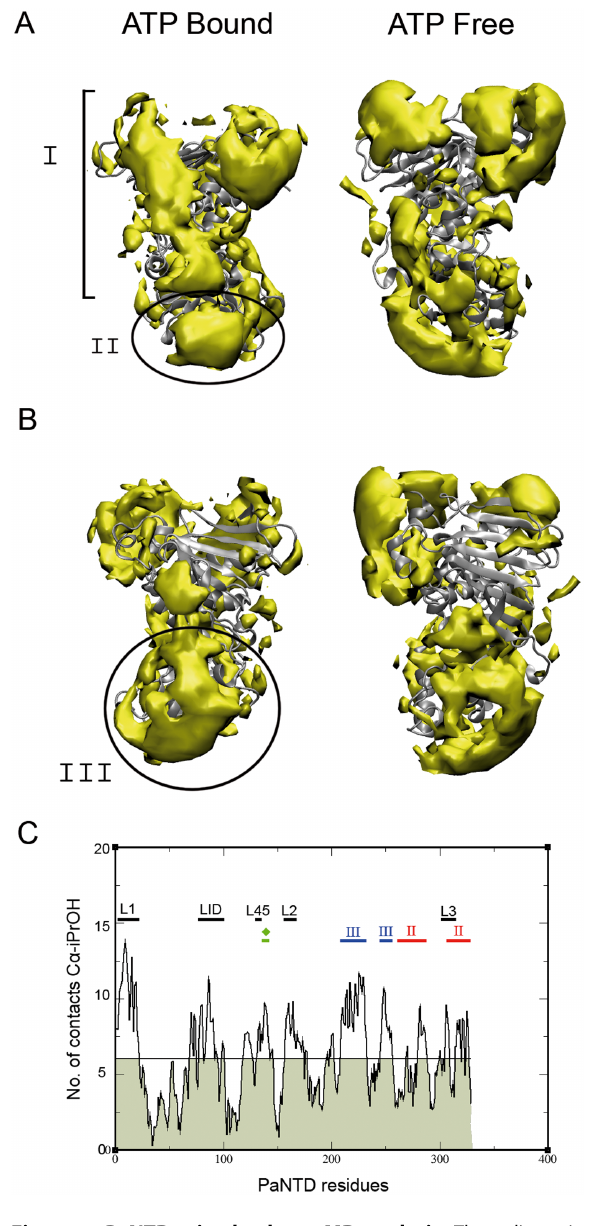
Figure 7. PaNTD mixed solvent MD analysis. Three-dimensional density distribution of iPrOH in ATP bound and unbound PaNTD is